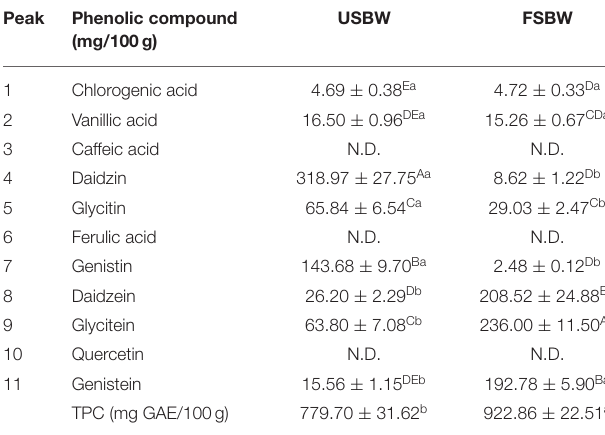
TABLE 1 | Phenolic profile of USBW and FSBW.